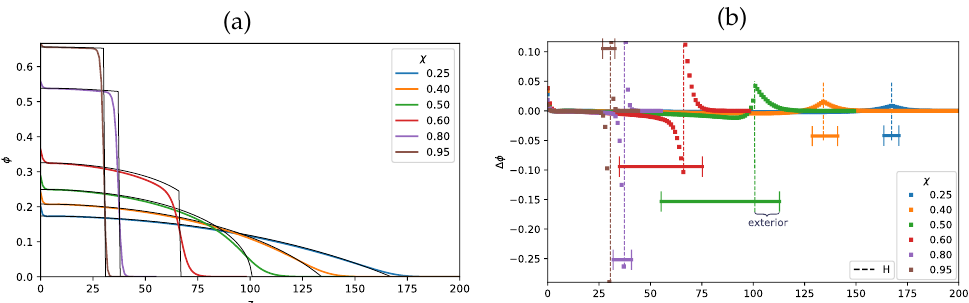
Figure 6. Polymer volume fraction profile calculated by the numerical SF-SCF method ( φ ) and within analytical SS-SCF approximation ( φ ) for selected values of χ parameter, SF SS ( 0.25;0.40;0.50;0.60;0.80;0.95 ) for N = 1000, σ = 0.02, planar surface, R = ∞ ( a ) The difference, ∆ φ ( z ) = φ ( z ) − φ ( z ) , between numerically and analytically calculated polymer density profiles SF SS for the same selected values of the χ -parameter ( b ). Here, z is a distance from the grafting surface or the number of the layer for lattice SF-SCF model. In panel ( b ) the brush thickness calculated by analytical method is indicated by dashed vertical lines, and horizontal bars shows the total range (cid:101) of Gaussian fluctuations, separated by the dashed vertical line into interior and exterior regions of the brush.